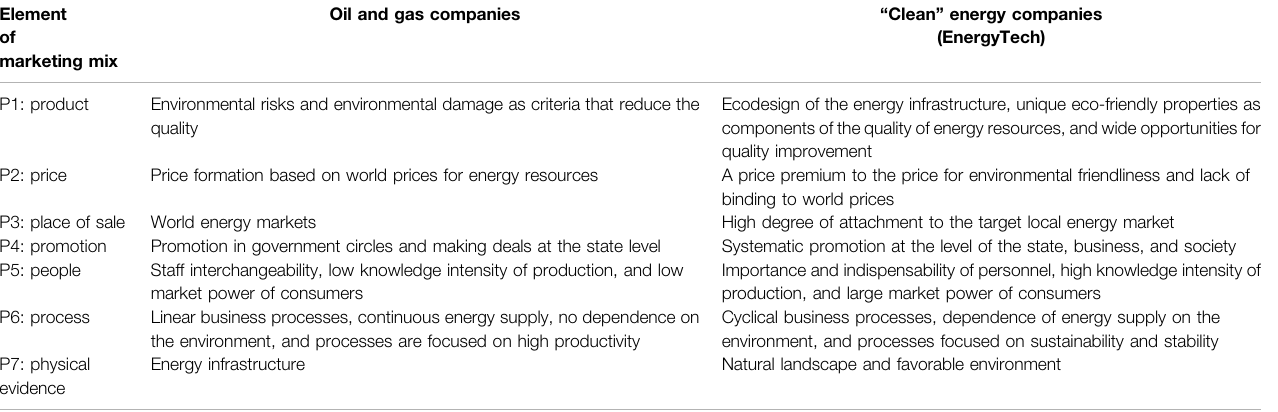
TABLE 1 | Comparative analysis of the marketing mix of “ clean ” energy companies and oil and gas companies. Element